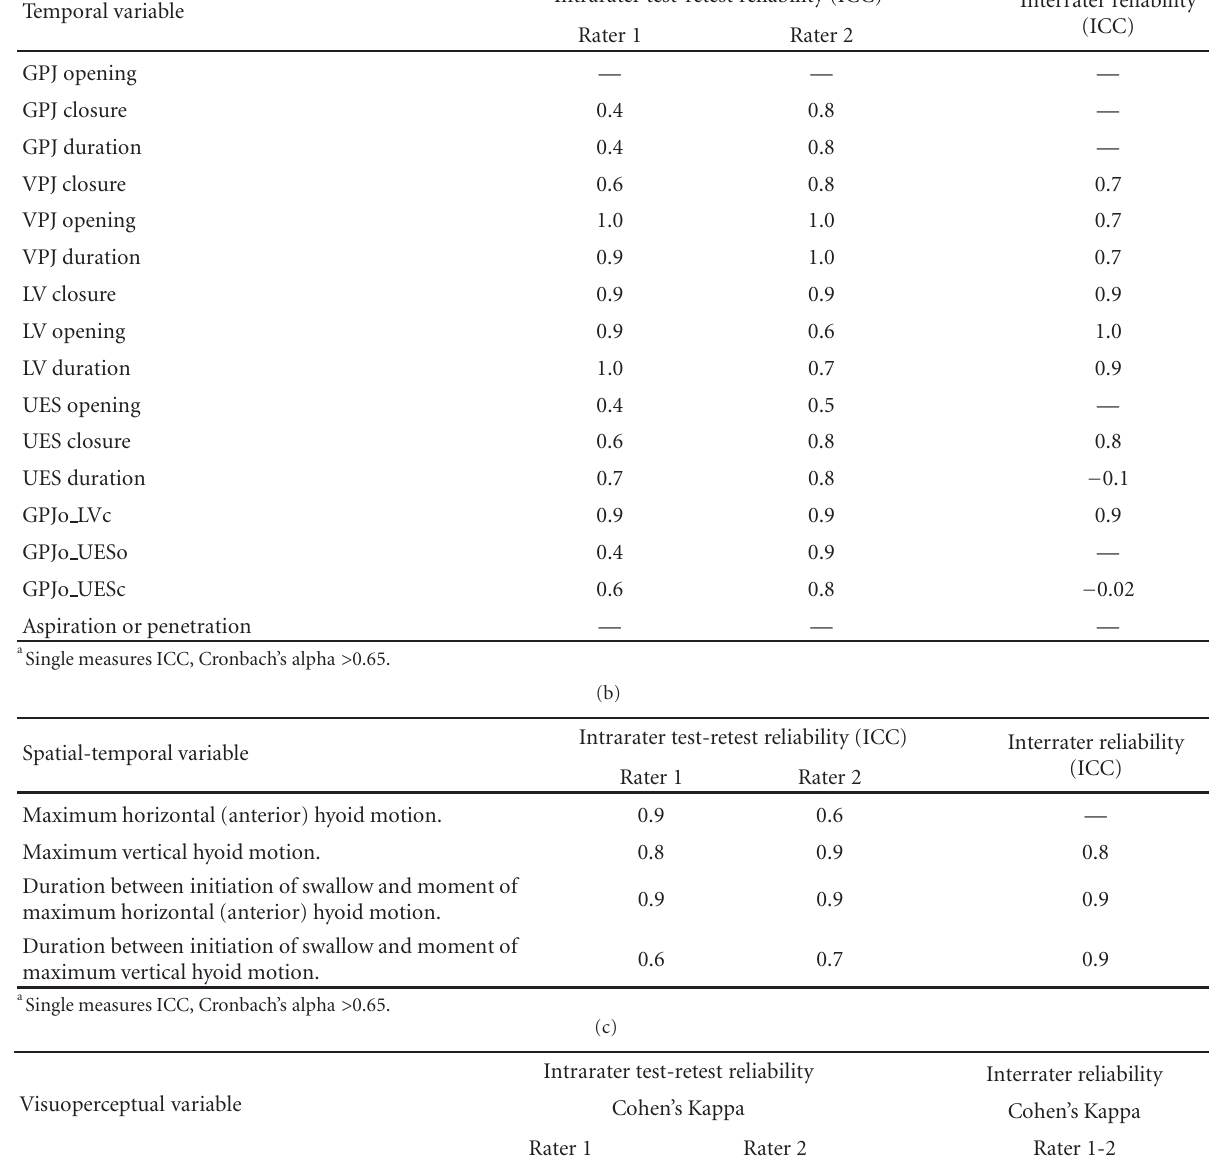
Table 3: (a) Reliability of the temporal variables (quantitative assessment), intraclass correlation coe ffi cients (ICC) a . (b) Reliability of the spatial-temporal variables (hyoid motion), ICC a . (c) Reliability of the visuoperceptual variables (qualitative assessment), Cohen’s